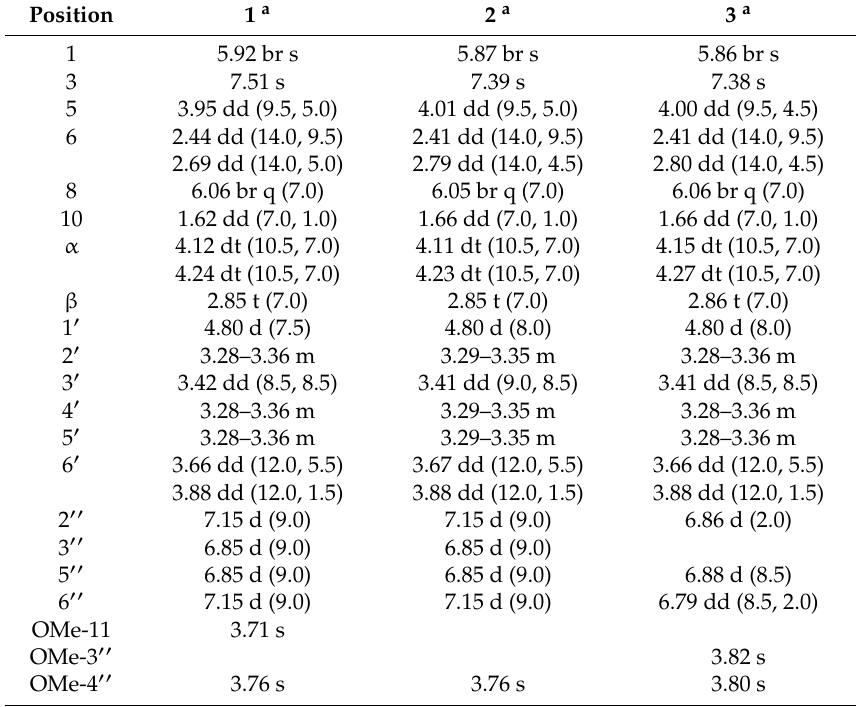
Table 1. 1 H-NMR data for compounds 1 – 3 ( δ in ppm, J in